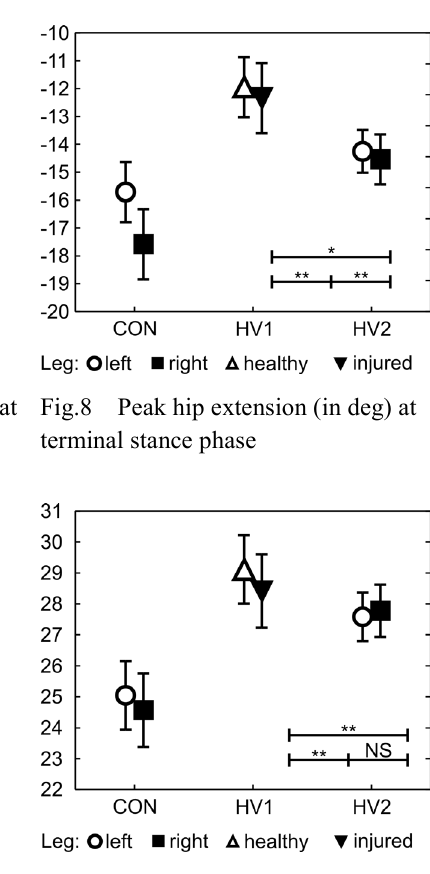
Fig.10 Peak hip flexion (in deg) at terminal swing phase